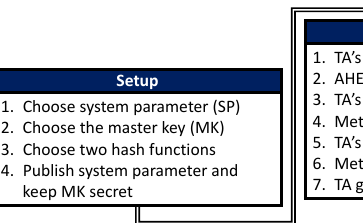
Figure 6. Algorithm of